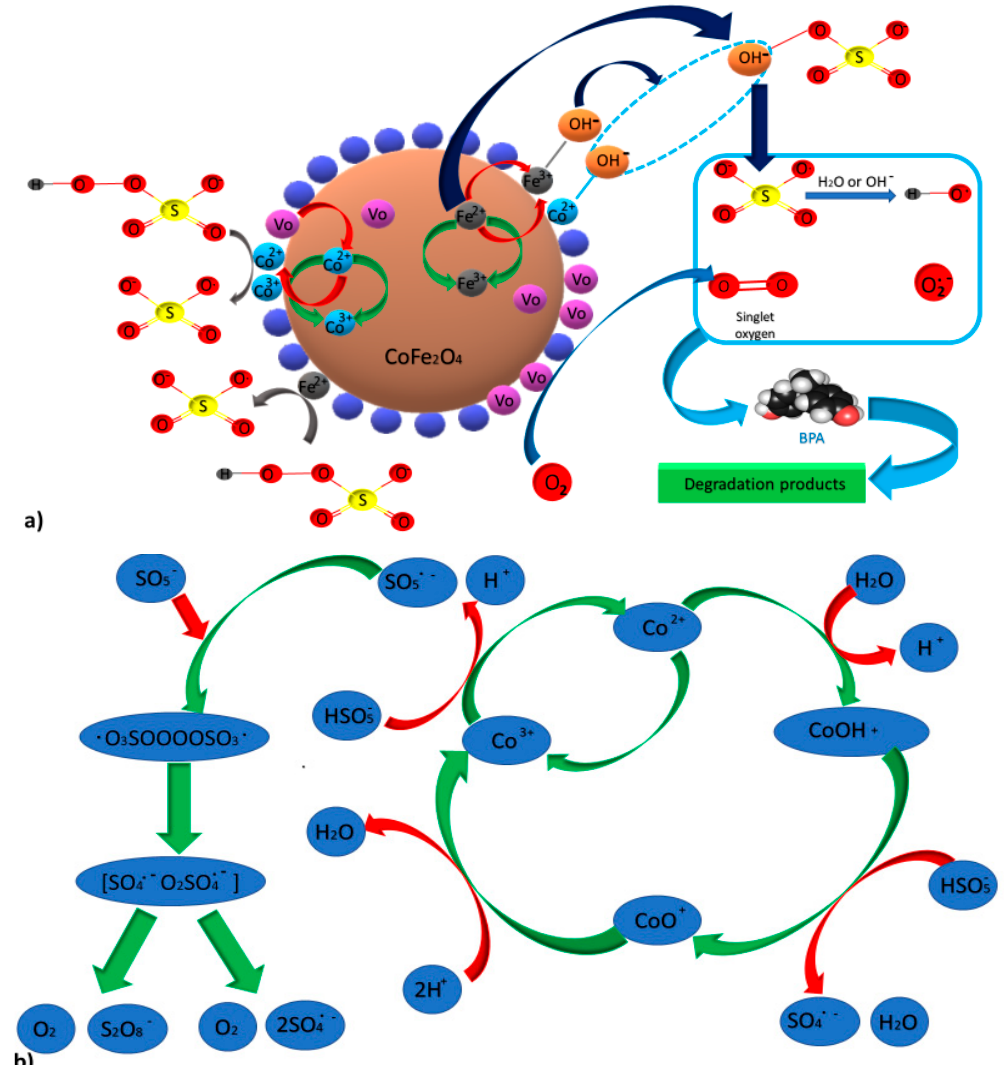
Figure 7. ( a ) The reactive species and reaction pathways for BPA degradation by CoFe 2 O 4 spinel and ( b ) The series of reactions for the formation of sulfate radicals by PMS/CoFe 2 O 4 spinel system [9,126].